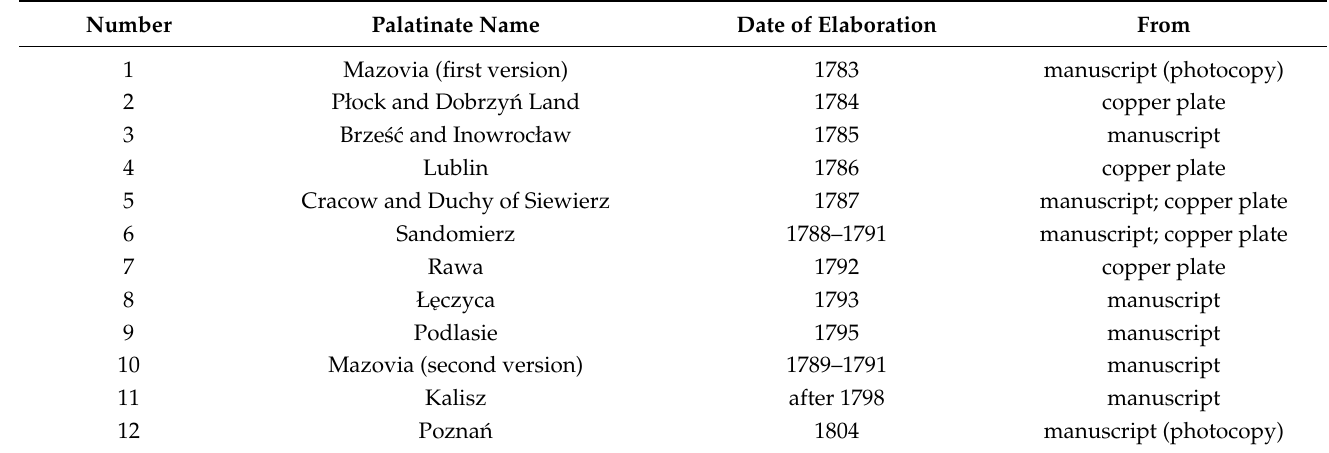
Table 1. A list of special maps with the dates of their elaboration and material form. Numbers correspond with numbers on the map in Figure